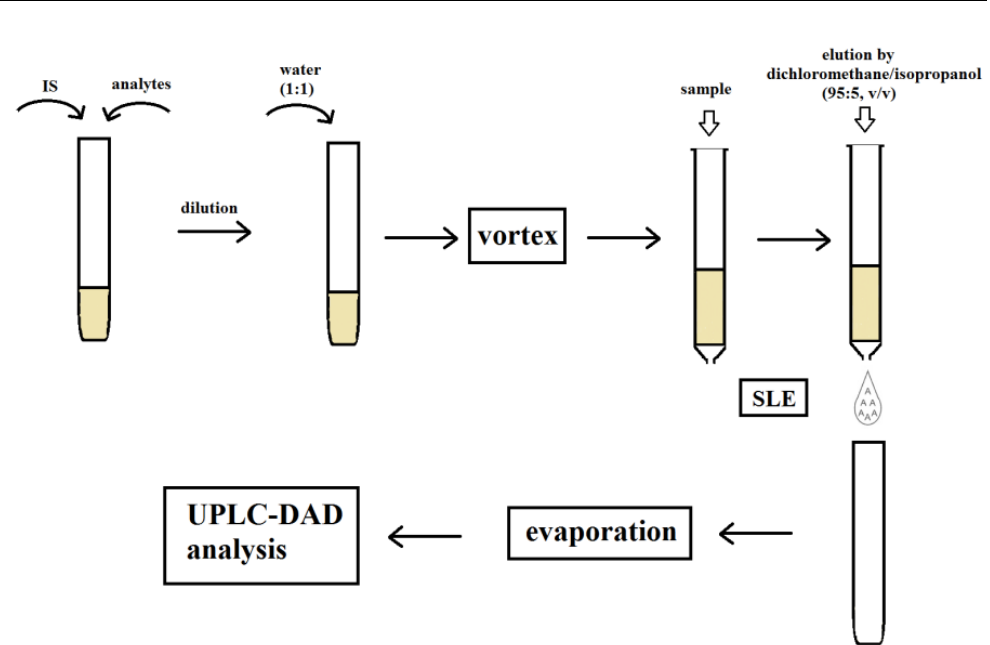
Figure 3. Final extraction procedure for antidepressant isolation.